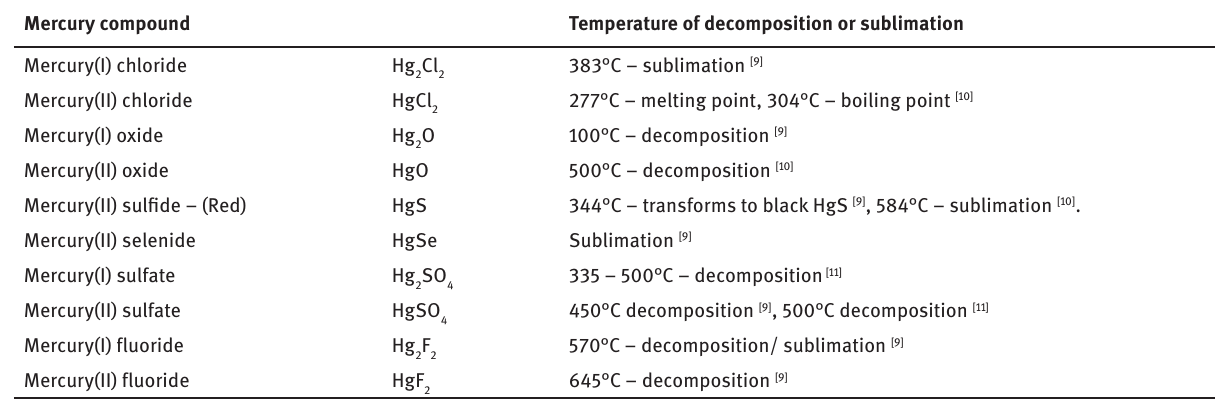
Table 1. Accessible literature data about the temperature characteristics of mercury compounds.